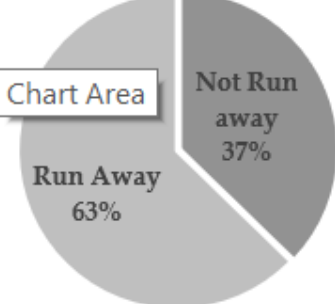
Figure 9. Circumstance of the death-October 2017